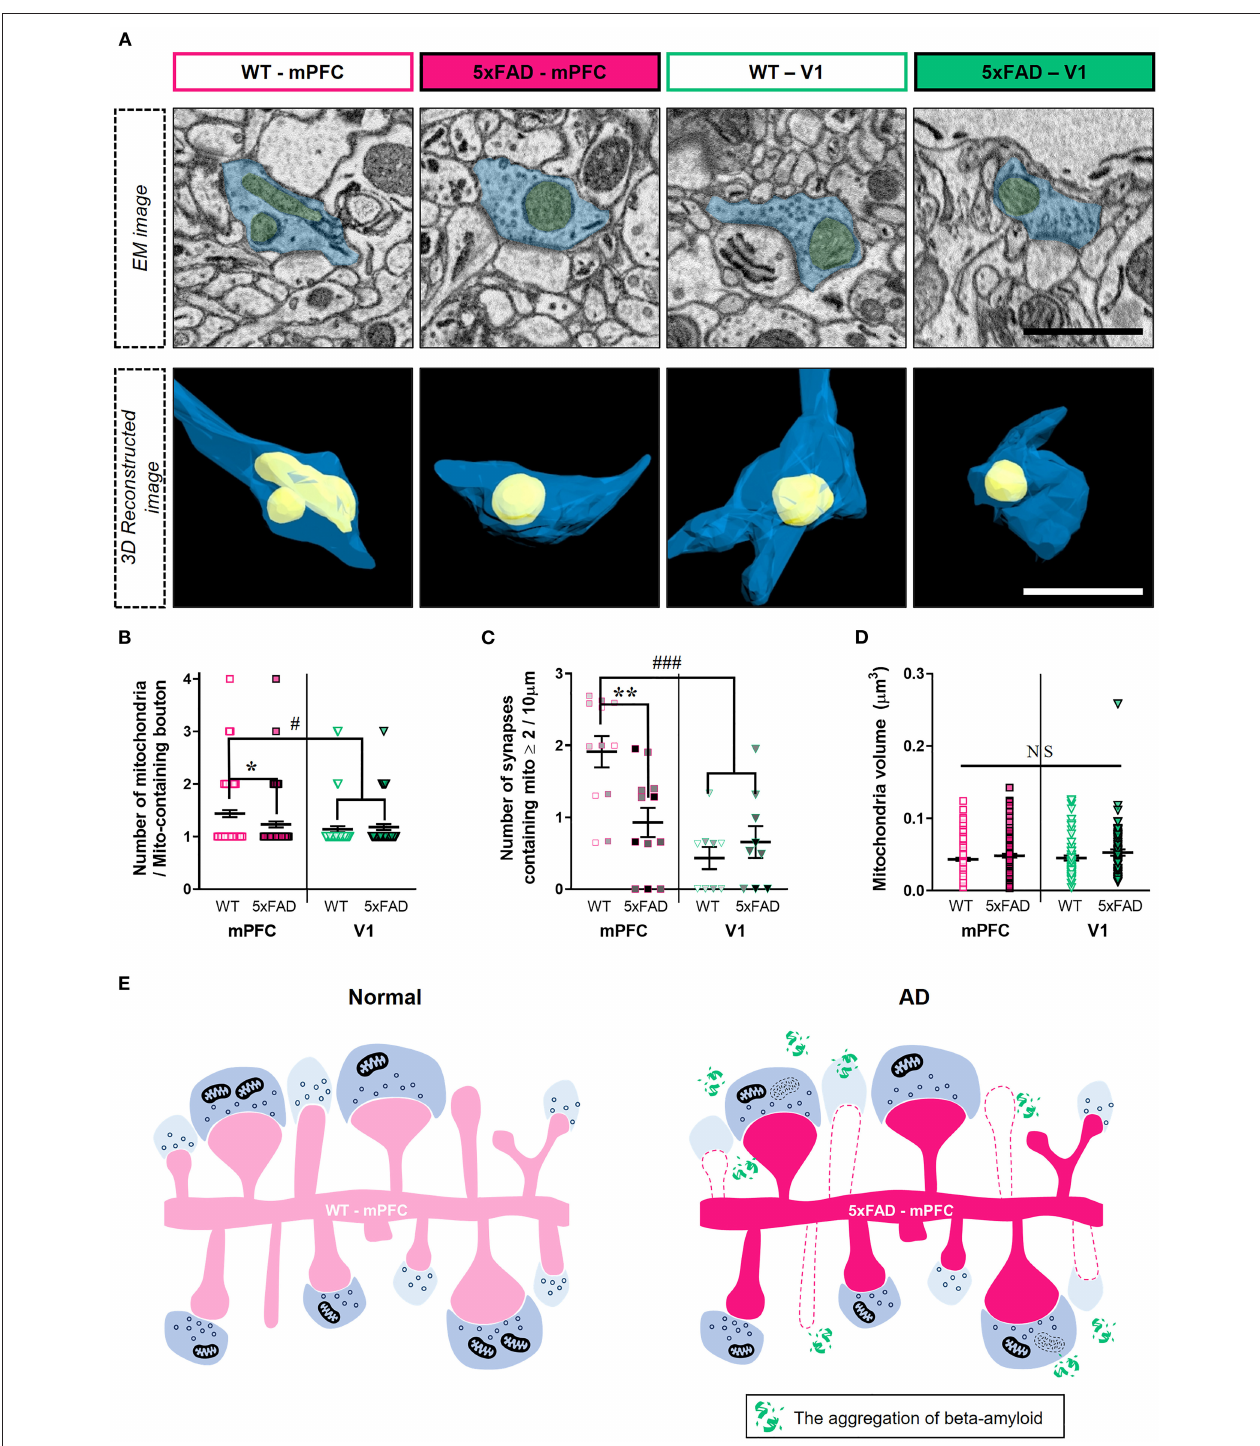
FIGURE 4 | Reduced number of boutons containing multiple-mitochondria in the 5xFAD mPFC. (A) Representative EM (top) and reconstructed (bottom) images of presynaptic boutons containing mitochondria in the mPFC and V1 of WT and 5xFAD mice. Blue, presynaptic bouton; yellow, mitochondria. (B) Quantification of the number of presynaptic mitochondria per bouton ( n = 61–96 boutons per group). * P < 0.05, # P < 0.05; Kruskal–Wallis test with post-hoc Dunn test. (C) The density of synapses containing multiple mitochondria ( n = 9–12 dendrites from 3 animals per group). ** P < 0.01, ### P < 0.001; two-way ANOVA with post-hoc Tukey test. The data points from each animal were displayed in the same color. (D) Average volume of individual mitochondria ( n = 71–138 per group). P > 0.38; Kruskal–Wallis test with post-hoc Dunn test. (E) Schematic model for synaptic alterations in the 5xFAD mPFC.